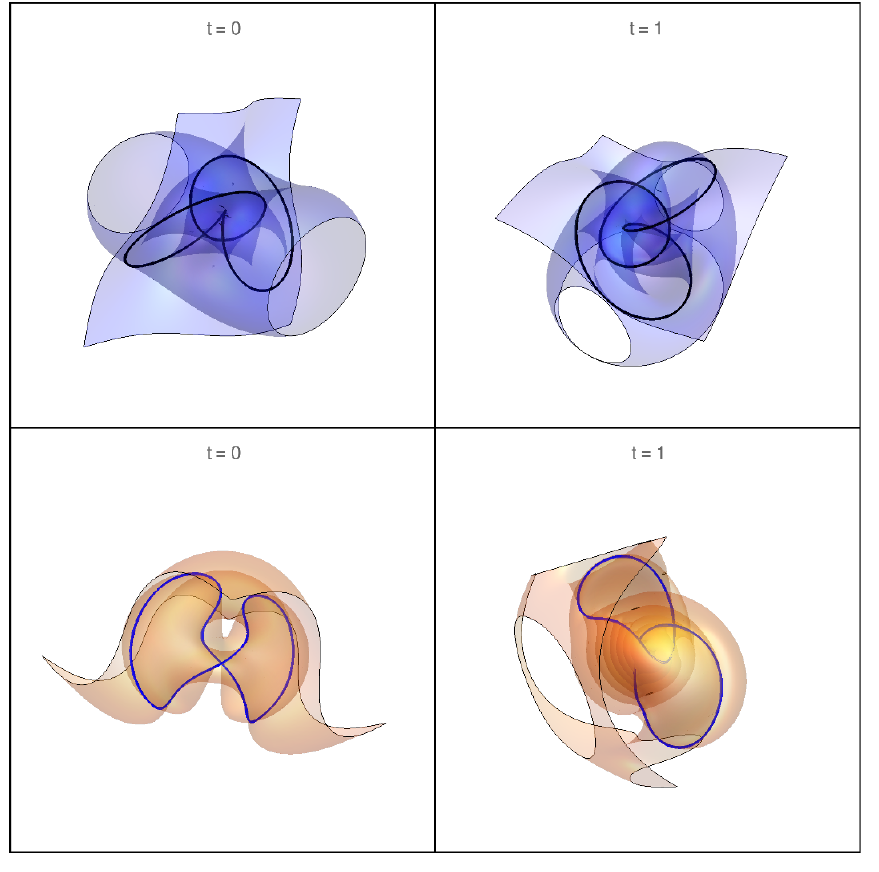
Figure 2 . The zeros of the Maxwell (top, in black) and Weyl (bottom, in blue) spinor obtained by the intersections of the real and imaginary parts of the complex (cid:31) (in blue) and M (in orange) for ( m = 3 ; n = 2). Plots are shown at t = 0 and t = 1